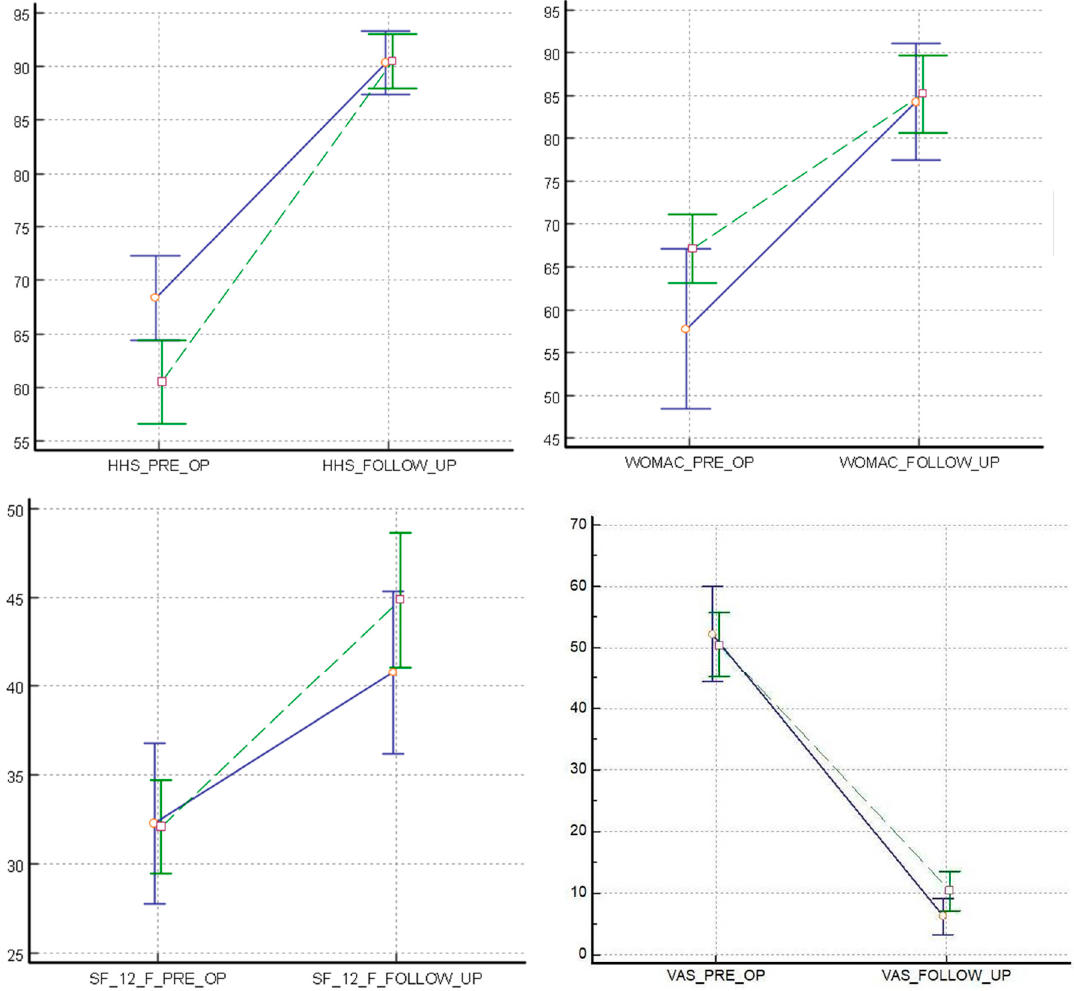
Figure 2. Trends in clinical scales before and after surgery in the two groups (SS—dashed green line vs TS—solid blue line). x: clinical scale evaluated; y: scores recorded. HHS: Harris Hip Score; WOMAC: Western Ontario and McMaster Universities Osteoarthritis Index; SF-12: 12-item Short Form Health Survey; VAS: Visual Analogue